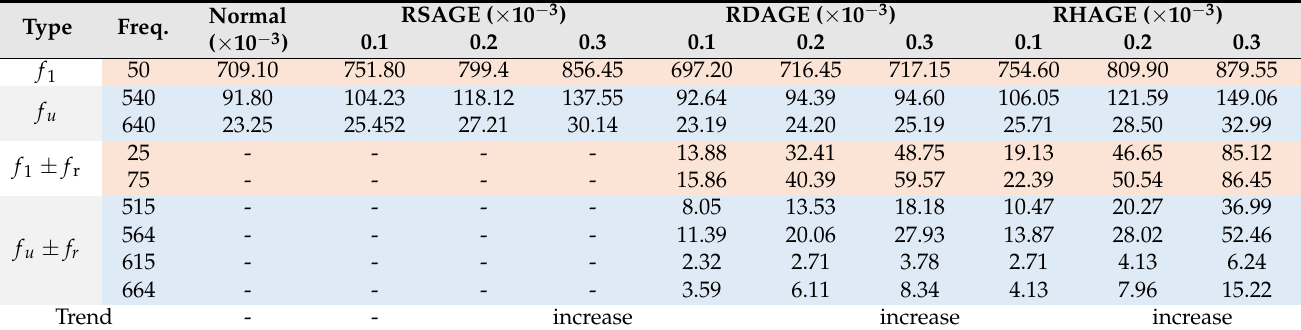
Table 5. Simulation results of